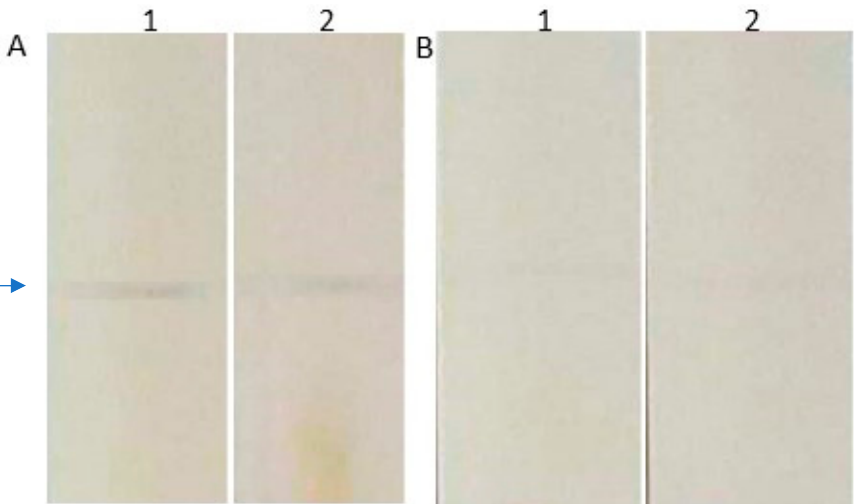
Figure 4. Evaluation of B19V particles' presence in serum samples by MAPIA. In this assay, the immunocomplex of mouse anti-B19V monoclonal antibody/ B19V VP1-VP2 capsid proteins was revealed by goat IgG anti-mouse-peroxidase (arrow). ( A ) Serum sample (H10) with B19V DNA detectable before ( 1 ) and after benzonase pretreatment ( 2 ). ( B ) Serum sample (H09) with B19V DNA undetectable before ( 1 ) and after benzonase pretreatment ( 2 ).